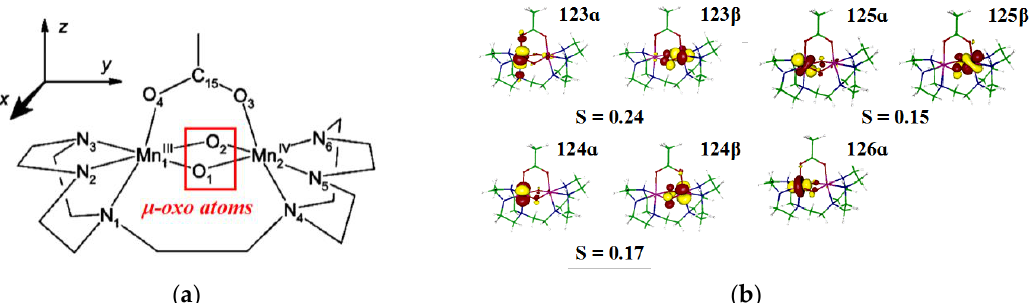
Figure 9. ( a ) Structure and atomic label of [Mn III Mn IV ( μ -O) 2 ( μ -OAc)DTNE] 2+ . ( b ) MOs 123–126 of this compound at bs state calculated utilizing B3LYP functional. Four α unpaired electrons and three β ones present three potential superexchange pathways, respectively, indicating interaction passes through µ -oxo atoms: MO 123 represents a crossed σ / π pathway containing in-plane oxo p -orbitals, and MOs 124 and 125 can be characterized as symmetric π / π pathways involving metal d -orbitals and out-of-plane oxo p -orbitals (adapted with permission from [59]).